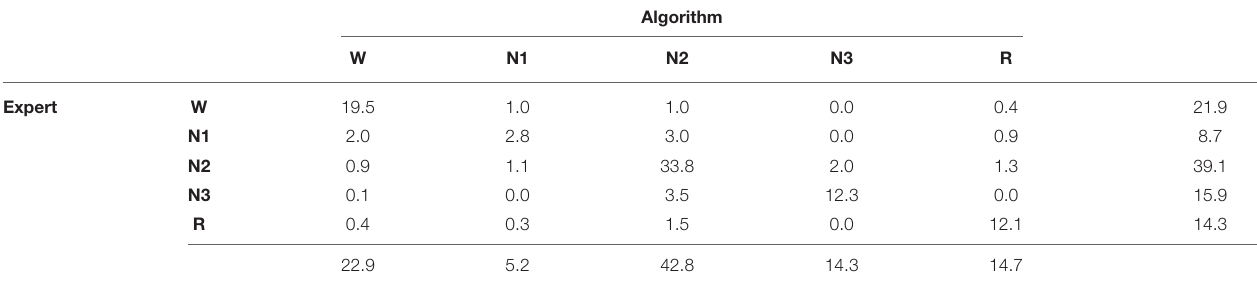
TABLE 2 | Confusion matrix for the single-scored dataset, including row and column totals, comparing the experts’ sleep stages to the predicted sleep stages.